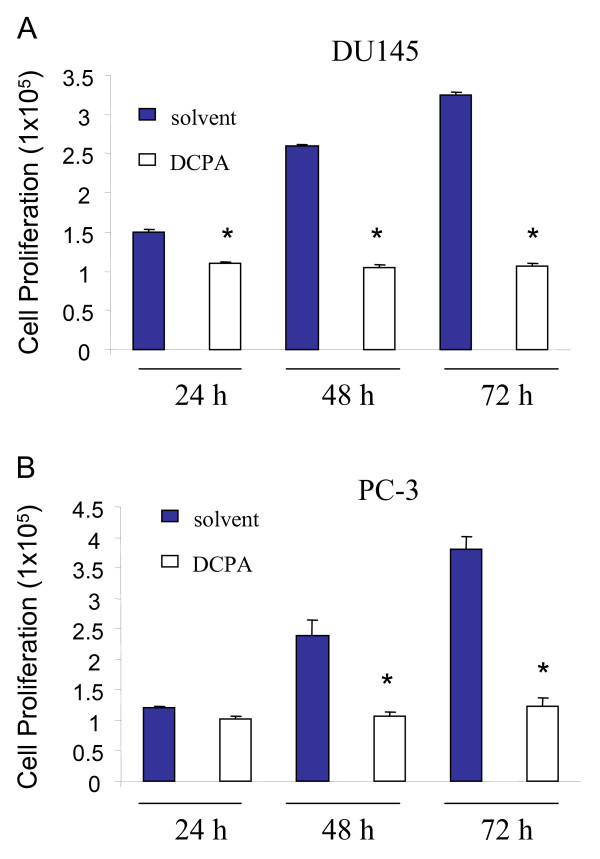
Proliferation of prostate cancer cells was inhibited by DCPA. DU145 (A) and PC-3 (B) cells were seeded at 100,000 cells per well one day before the addition of DCPA. The cells were incubated in the presence (+) or absence (-) of 150 μM DCPA for 24, 48, and 72 h, as indicated. The cell proliferation assay was performed as described in Materials and Methods. The results are expressed as mean of cell number from replicate experiments. Bars, SD. * indicates significant difference when compared to cell proliferation without DCPA at the same time point (P < 0.01).